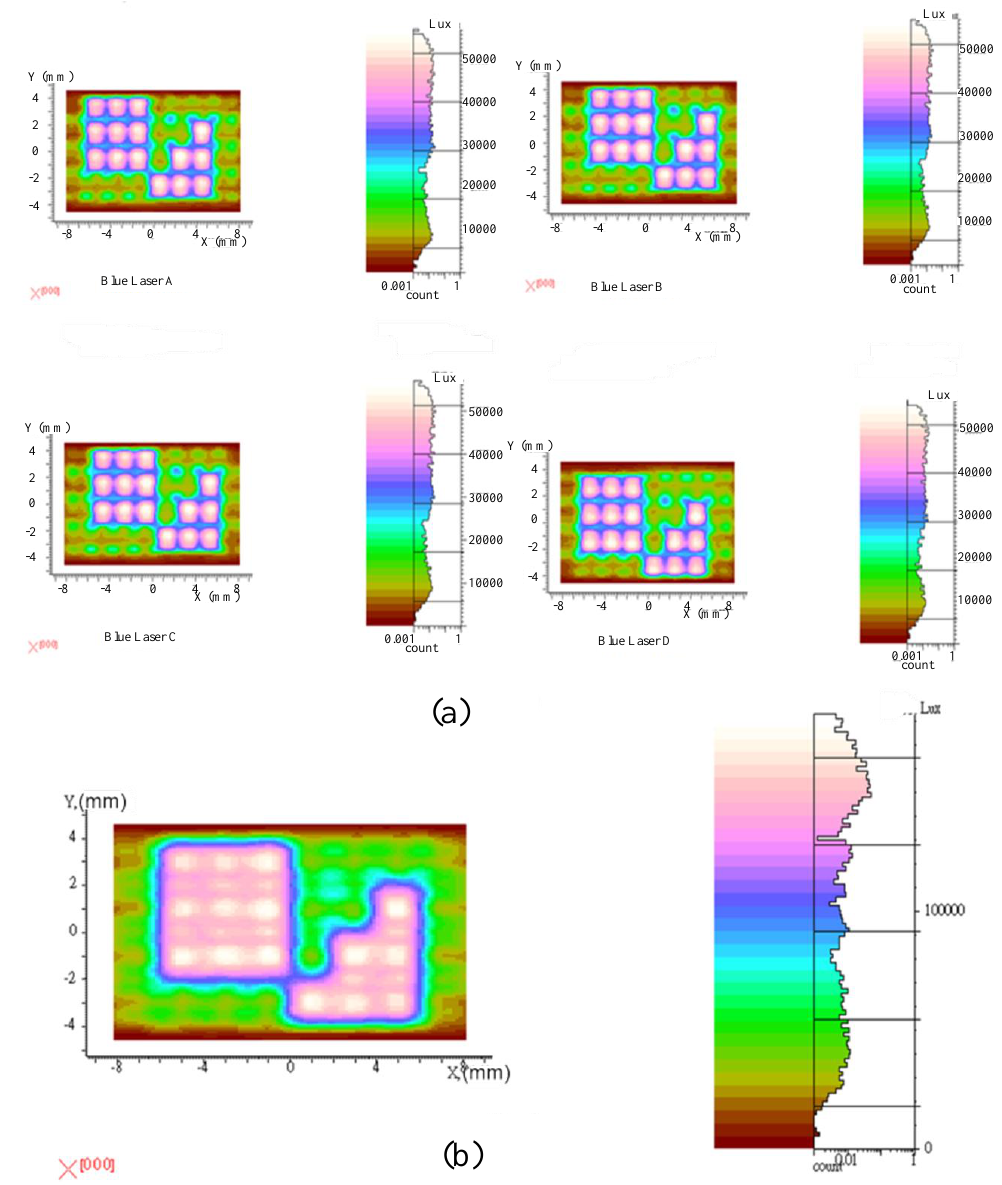
Figure 16. ( a ) Single blue laser, displaying displacement map for local dimming (liquid crystal lens with pore size of 2.0mm and a focal length of 23 cm). ( b ) Four blue lasers, displaying compensation for light source micro scanning (liquid crystal lens with pore size of 2.0 mm and a focal length of 23 cm). Table 7. Contrast and light efficiency for a single red laser and cyclic micro-scanning laser (liquid crystal lens with pore size of 2.0 mm and a focal length of 23 cm). Brightness Laser A Laser B Laser C Laser D Cyclic Laser 443163.875 428650.5 432997.3 1216329.25 Darkest spot of the optical spot (unit: